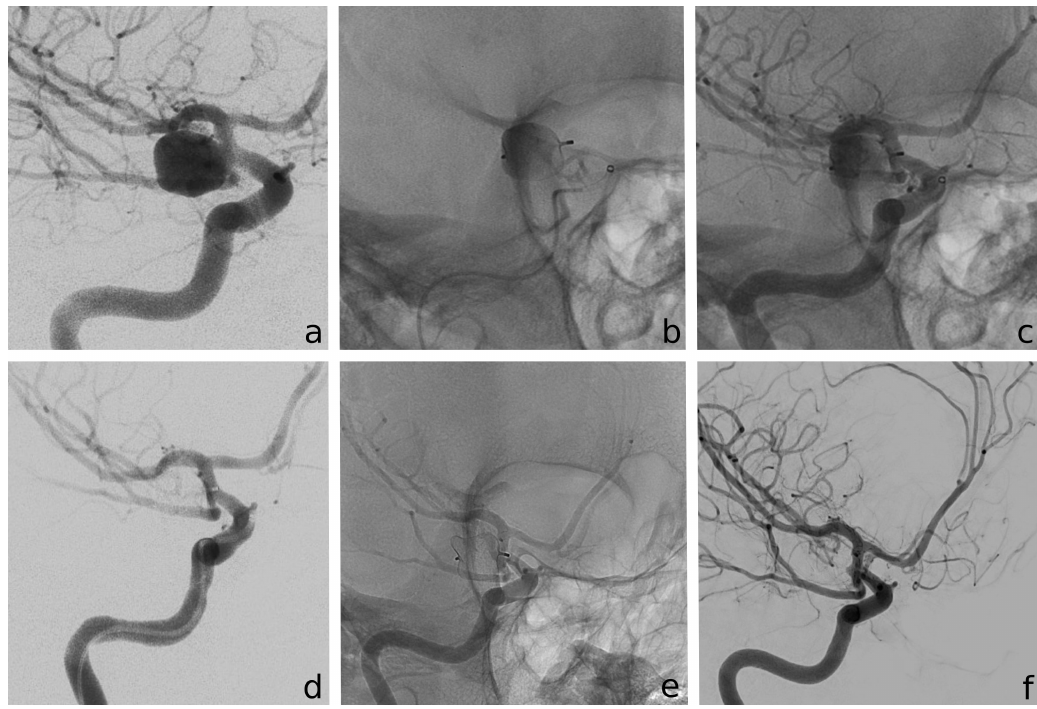
Fig. 3. DSA of intravascular device placement for the treatment of a ruptured PComA aneurysm. 45 years old woman with unruptured PComA aneurysms (a). Intravascular device deployment (b,c) with complete aneurysm (d) occlusion. Six-months follow-up DSA shows the aneurysm’s complete occlusion